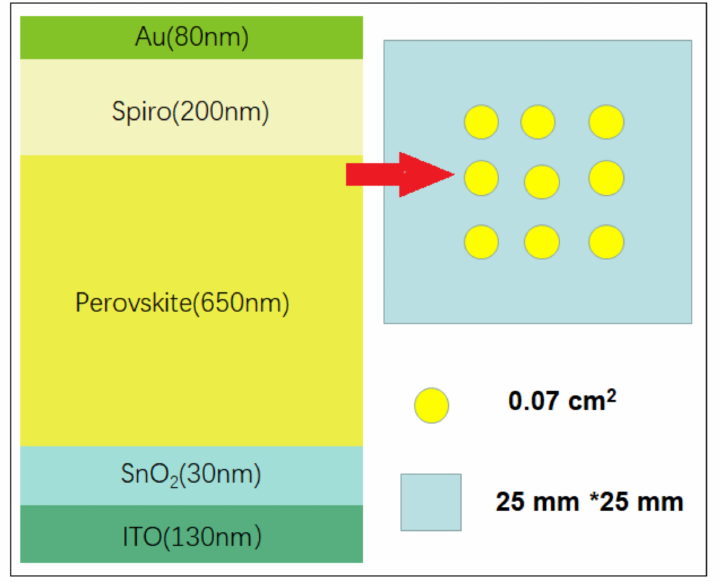
Figure 1. Cell structures of PSCs manufactured by Xi’an Jiaotong